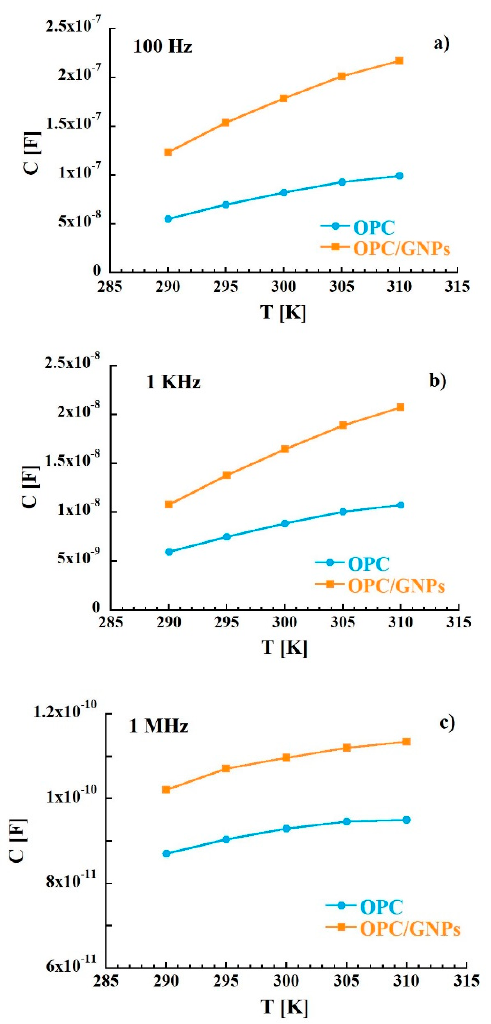
Figure 4. Temperature dependence of the capacitance as at 100 Hz ( a ), 1 KHz ( b ) and 1 MHz ( c ).